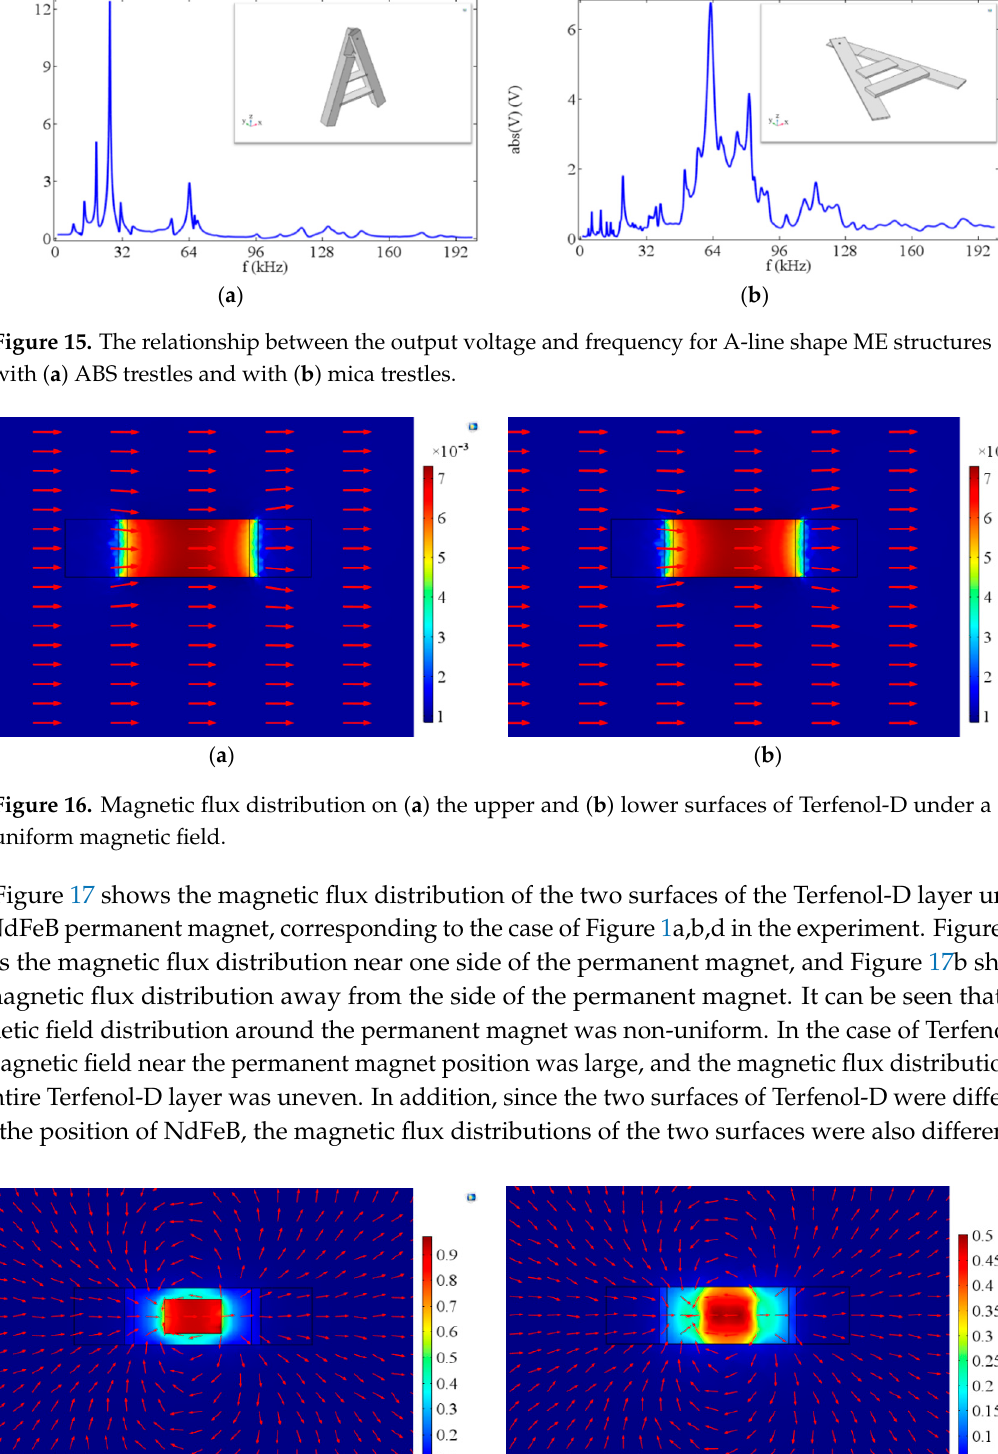
Figure 17. Magnetic flux distribution of Terfenol-D on ( a ) the surface near NdFeB and ( b ) the surface away from NdFeB under one NdFeB permanent magnet.